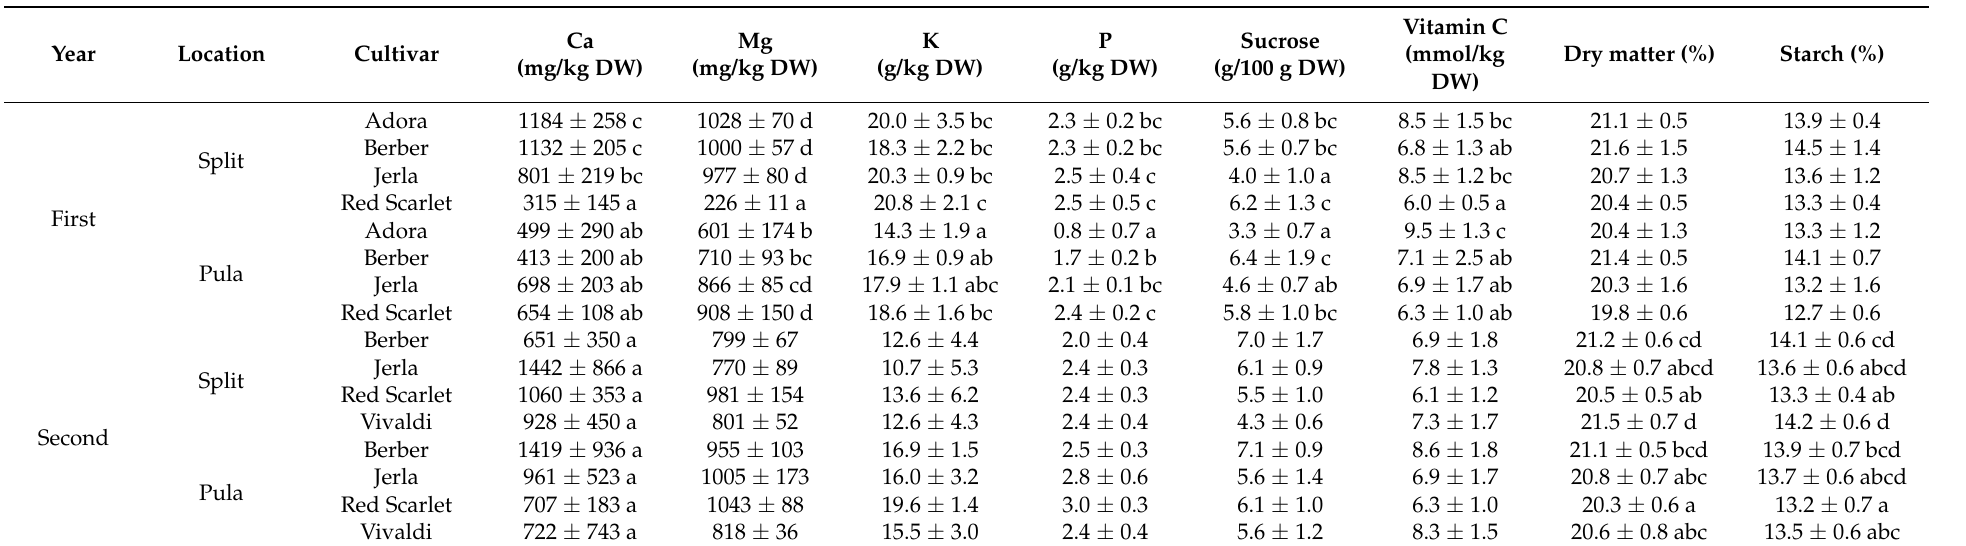
Table 4. Nutritional properties of potato tubers affected by the interaction between location and